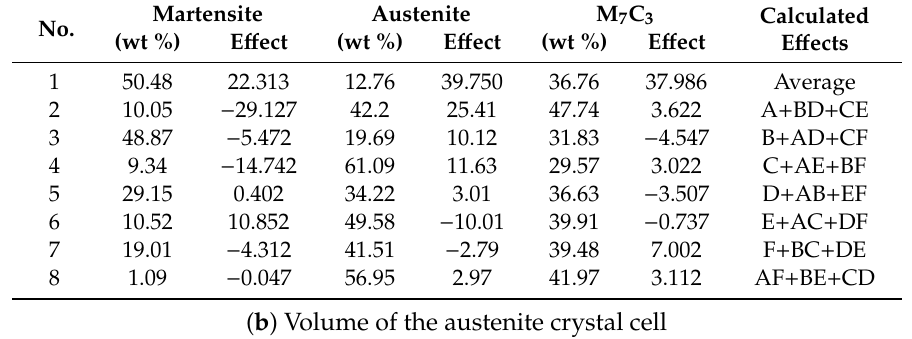
Table 6. Average values and e ff ects obtained for the analysed responses. ( a ) Percentage by weight of the phases present No.